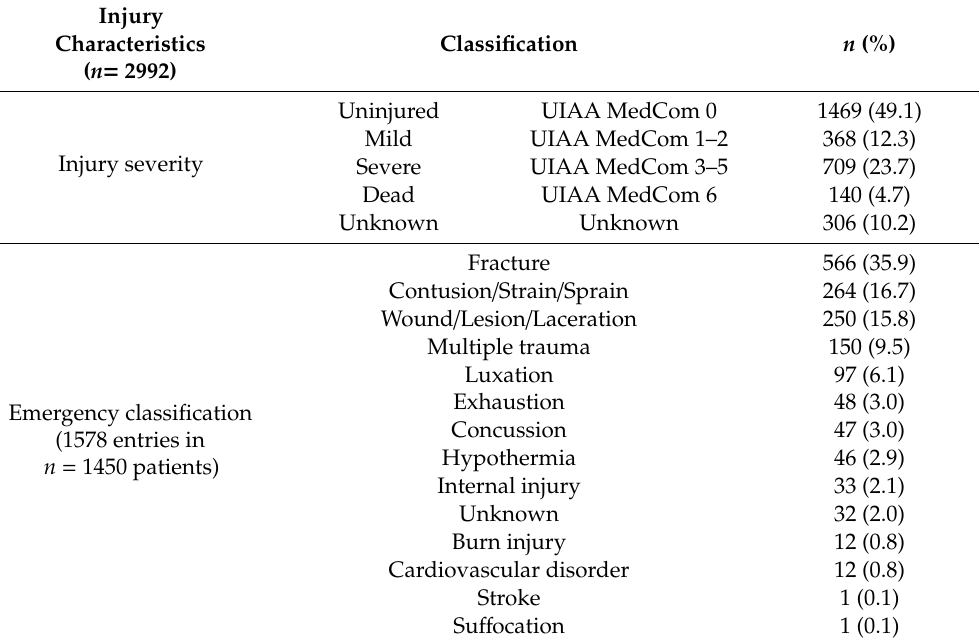
Table 2. Injury characteristics of rock climbing emergencies in Austria from 2005 to